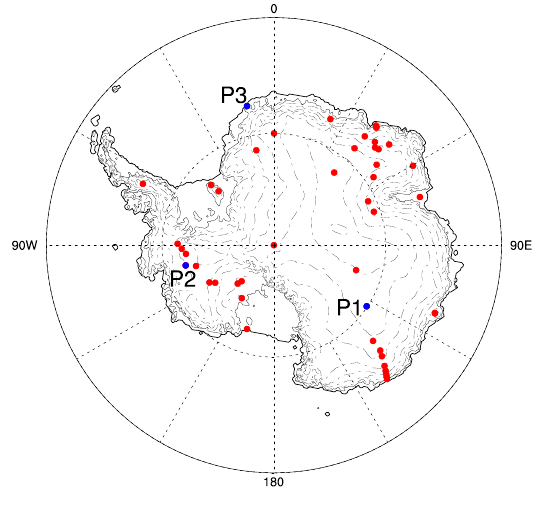
Fig. 2: Locations of 48 firn cores used in the model compar- ison in Sect. 2 (red and blue) and the locations of P1, P2 and P3, used in the analysis in Sect. 3.2